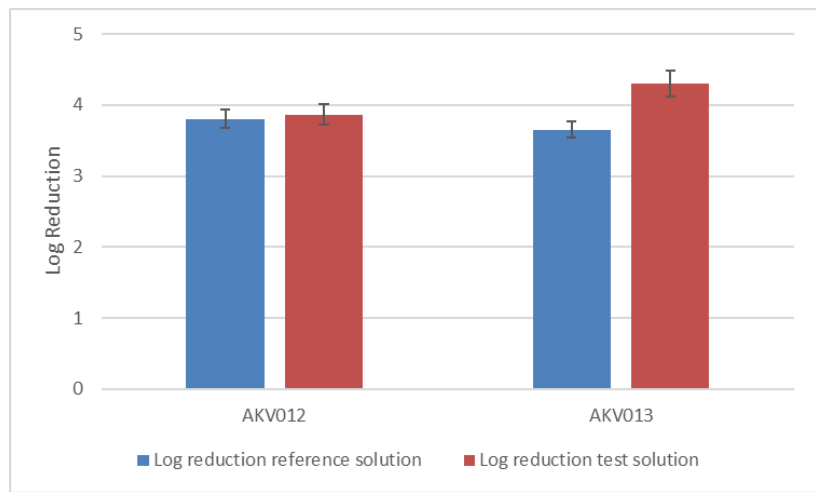
Figure 6. Log reduction ± SEM (standard error of mean) of AKVANO skin disinfectant sprays AKV012 and AKV013 compared to reference solution 2-propanol 60% ( v/v ).